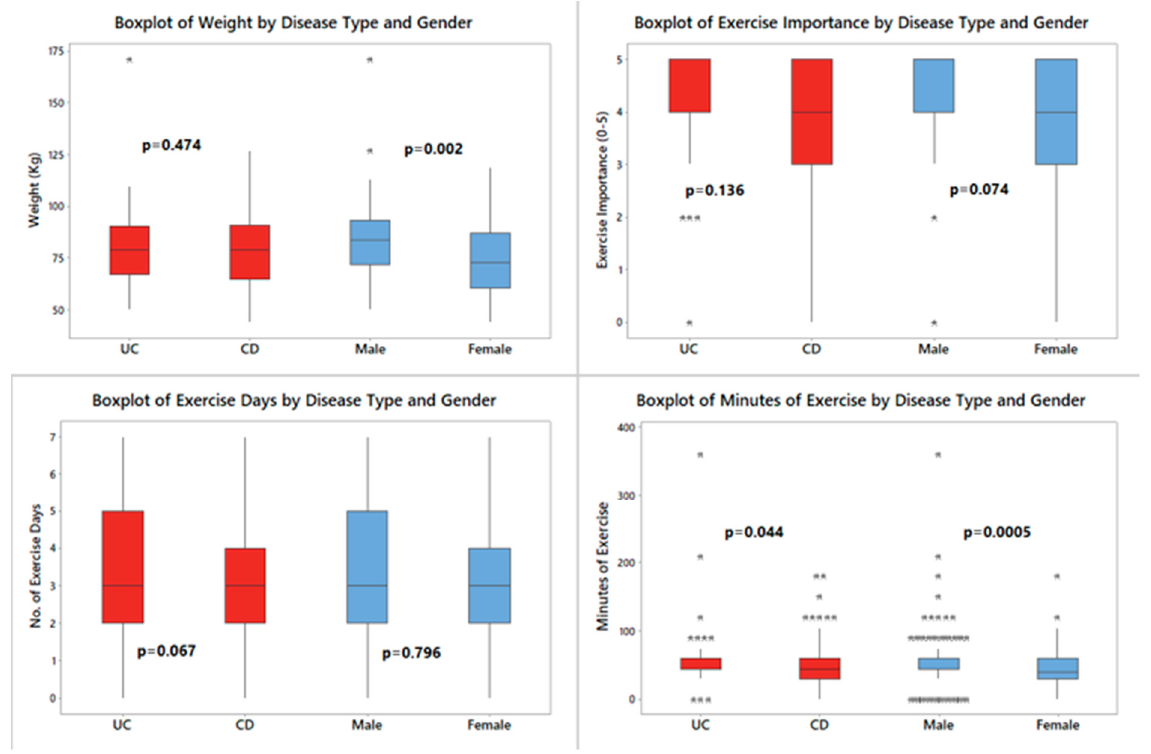
Figure 1. Results of disease- and gender-based weight and exercise patterns. UC—ulcerative colitis; CD—Crohn’s disease. Table 1. Patient demographics.